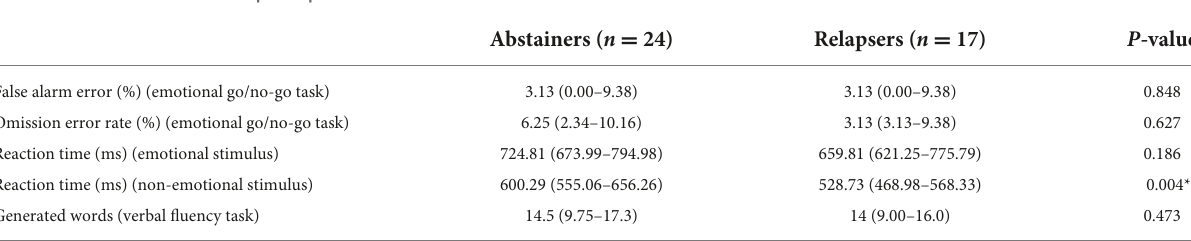
TABLE 2 Behavioral data of the